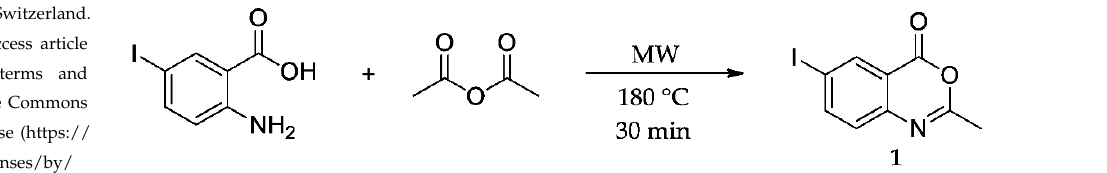
Figure 2. Synthesis of pyridine-2,6-dicarbohydrazide. Afterwards, the synthesis of the desired compound was performed mechanochemi- cally, using freshly prepared 6-iodo-2-methyl-4 H -benzo[ d ][1,3]oxazin-4-one ( 1 ) and pyri- dine-2,6-dicarbohydrazide ( 2 ) and1 mL of choline chloride:urea (1:2) deep eutectic solvent (DES) (Figure 3). The mixture was ball-milled for 20 min and upon completion of the re- action, water was added to the mixture. The new compound was recrystallized from methanol and obtained with 57% yield. The melting point, NMR and mass spectra were recorded. Figure 3. Synthesis of N 2 , N 6 -bis(6-iodo-2-methyl-4-oxoquinazolin-3(4 H )-yl)pyridine-2,6-dicarbox- amide. The 1 H NMR spectra reveal some characteristic peaks. Quinazolinone C-2 methyl protons show singlet peaks at 2.51 ppm, aromatic protons peaks are found at 7.52–8.47 ppm, while –NH- protons are found at 12.24 and 12.15 ppm. The 13 C NMR spectra also show peaks characteristic of a –CH 3 carbon at 21.8 ppm and characteristic aromatic carbon peaks (full spectra available in Supplementary Materials). This synthetic pathway has green character due to utilization of DES as a catalyst, which is biodegradable and non-toxic, while ball-milling proves to be time and energy efficient, yielding the final compound in high purity. The synthesis of similar compounds, using benzoxazinone and different amines, is usually performed conventionally, but in most cases requires longer times, higher temperatures or extensive purification [23–26]. 3. Materials and Methods All chemicals were purchased from commercial suppliers and were used as such. Choline chloride (99%) was purchased from Acros Organics (Geel, Belgium) and urea (p.a.) was purchased from Gram Mol. Aluminum plates coated with silica gel fluorescent indicator F254 (Kieselgel 60) were used for thin-layer chromatography, while benzene: acetone: acetic acid (8:1:1) was used as a mobile phase. TLC plates were monitored using HP-UVIS cabinet (Biostep GmbH). The Electrothermal IA9100 melting point apparatus